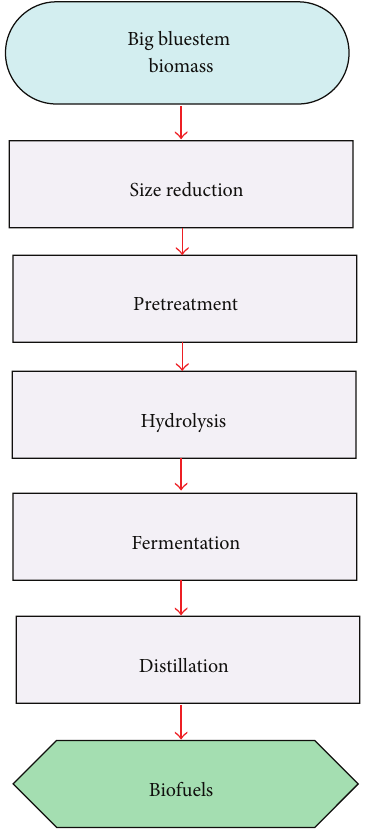
Figure 1: Major steps in biochemical conversion of big bluestem biomass into biofuels.